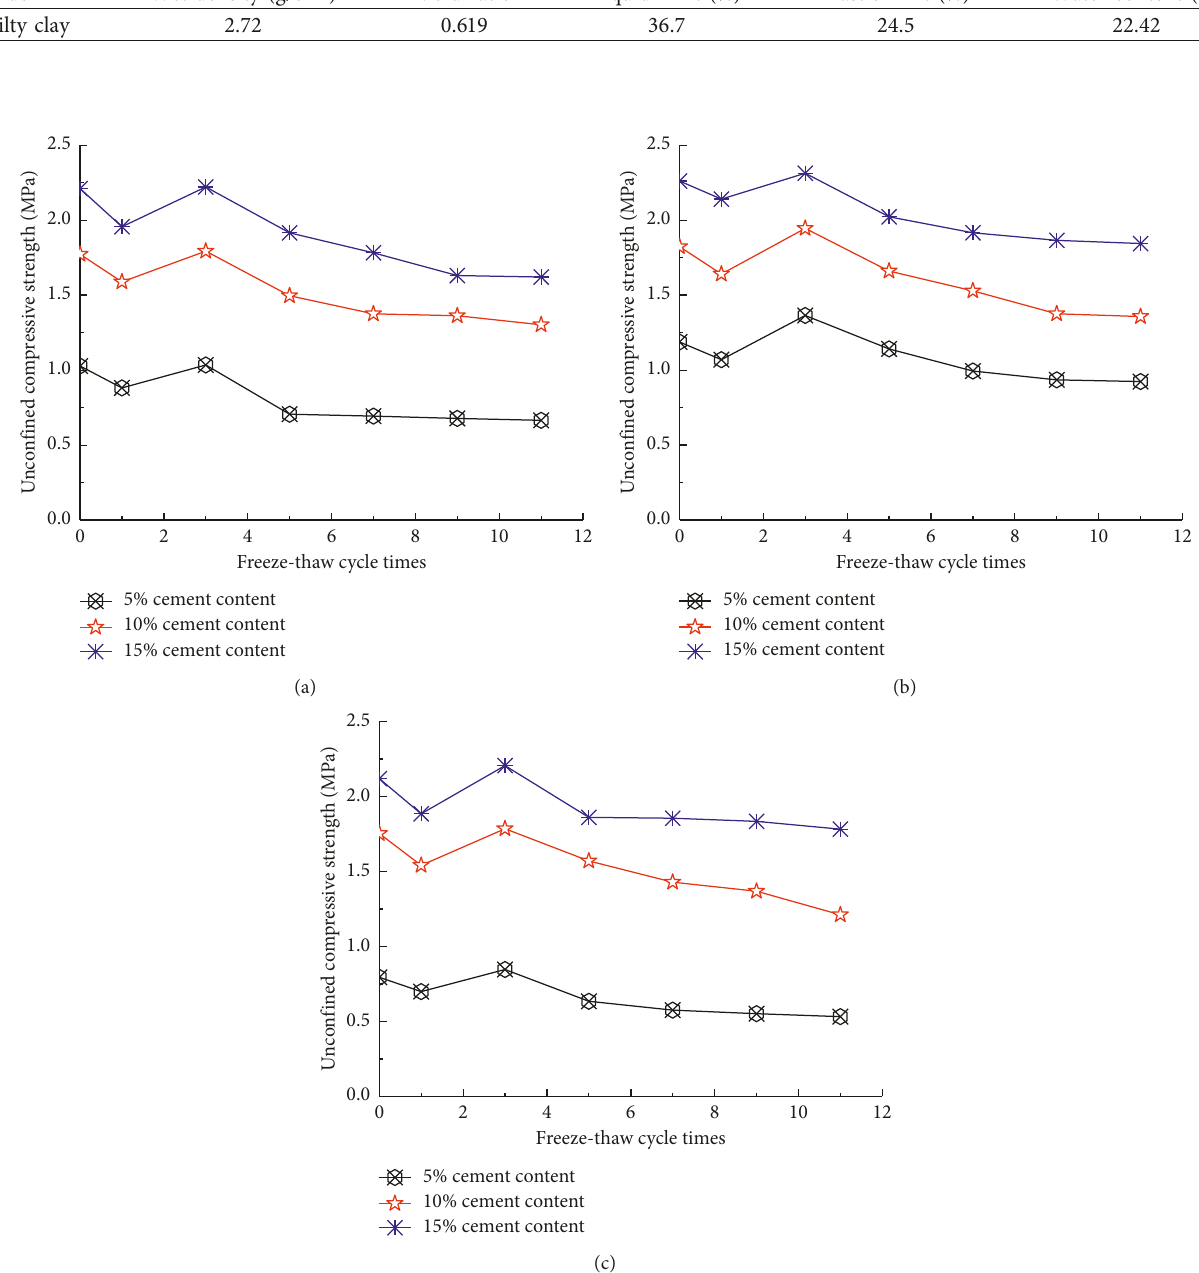
Figure 1: Relationship between unconfined compressive strength and times of freeze-thaw cycle of solidified/stabilized contaminated soils. (a) Pb 2+ concentration with 1000mg/kg; (b) Pb 2+ concentration with 5000mg/kg; (c) Pb 2+ concentration with 15000mg/kg.